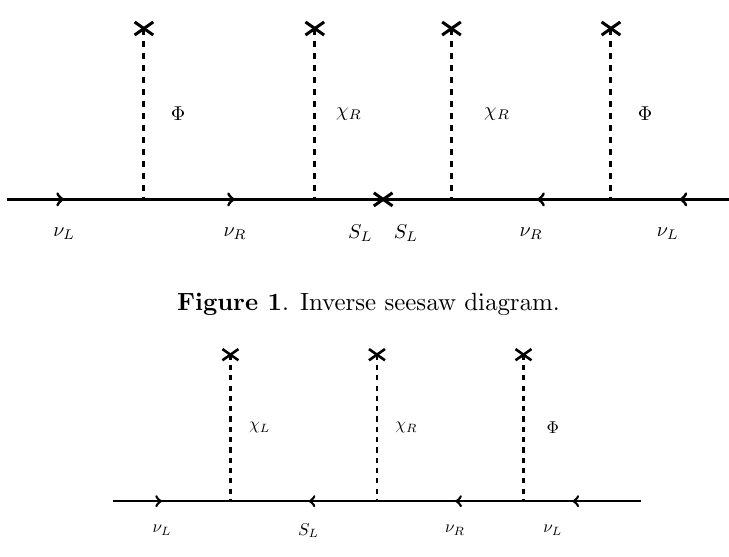
Figure 2 . Linear seesaw diagram, up to